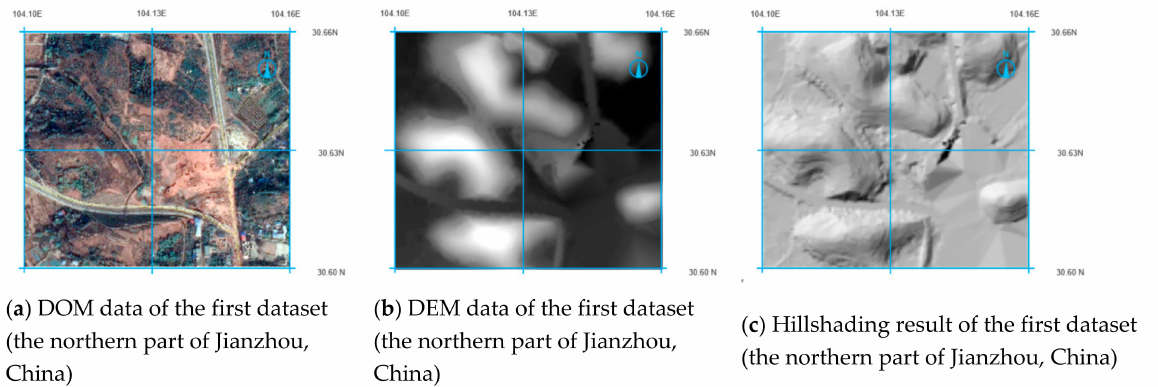
Figure 8. Experimental results for Dataset 1: ( a ) DOM data for Dataset 1 (Jianzhou); ( b ) DEM data for Dataset 1 (Jianzhou); ( c ) Hillshading results for Dataset 1